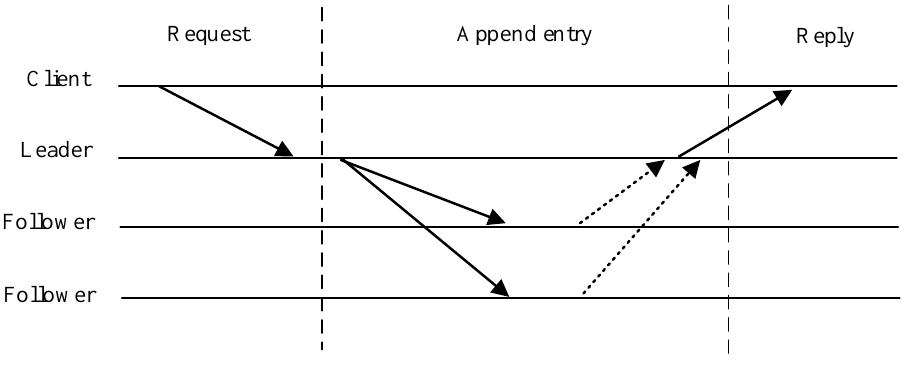
Figure 6. Log replication process.